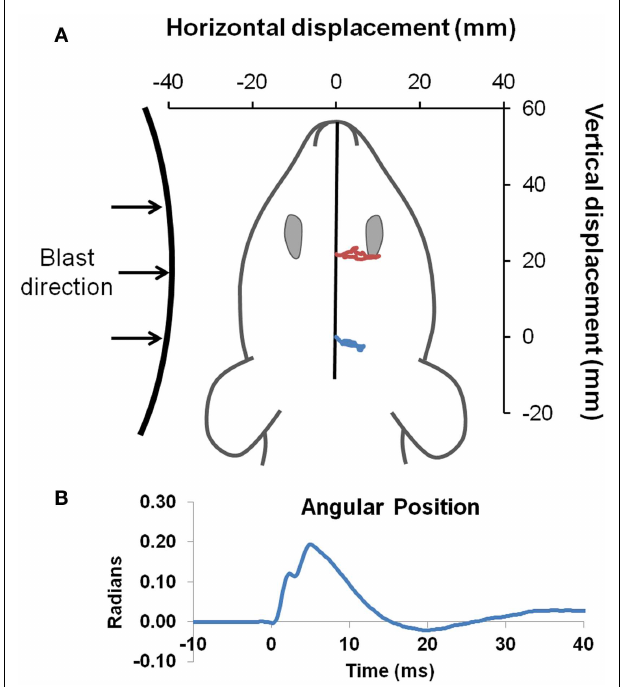
FIGURE 2 | Head kinematics during blast . Blast was directed to the left side of all animals (A) . Landmarks of ink placed between the eyes (red), and on the head (blue) were tracked with high-speed video to obtain head position (drawn to scale) during exposure to the blast wave, with an example of the high-blast shown. Angular position (B) was derived by intersection of a line passing through the two points compared to the initial position of the head, and demonstrated only limited head